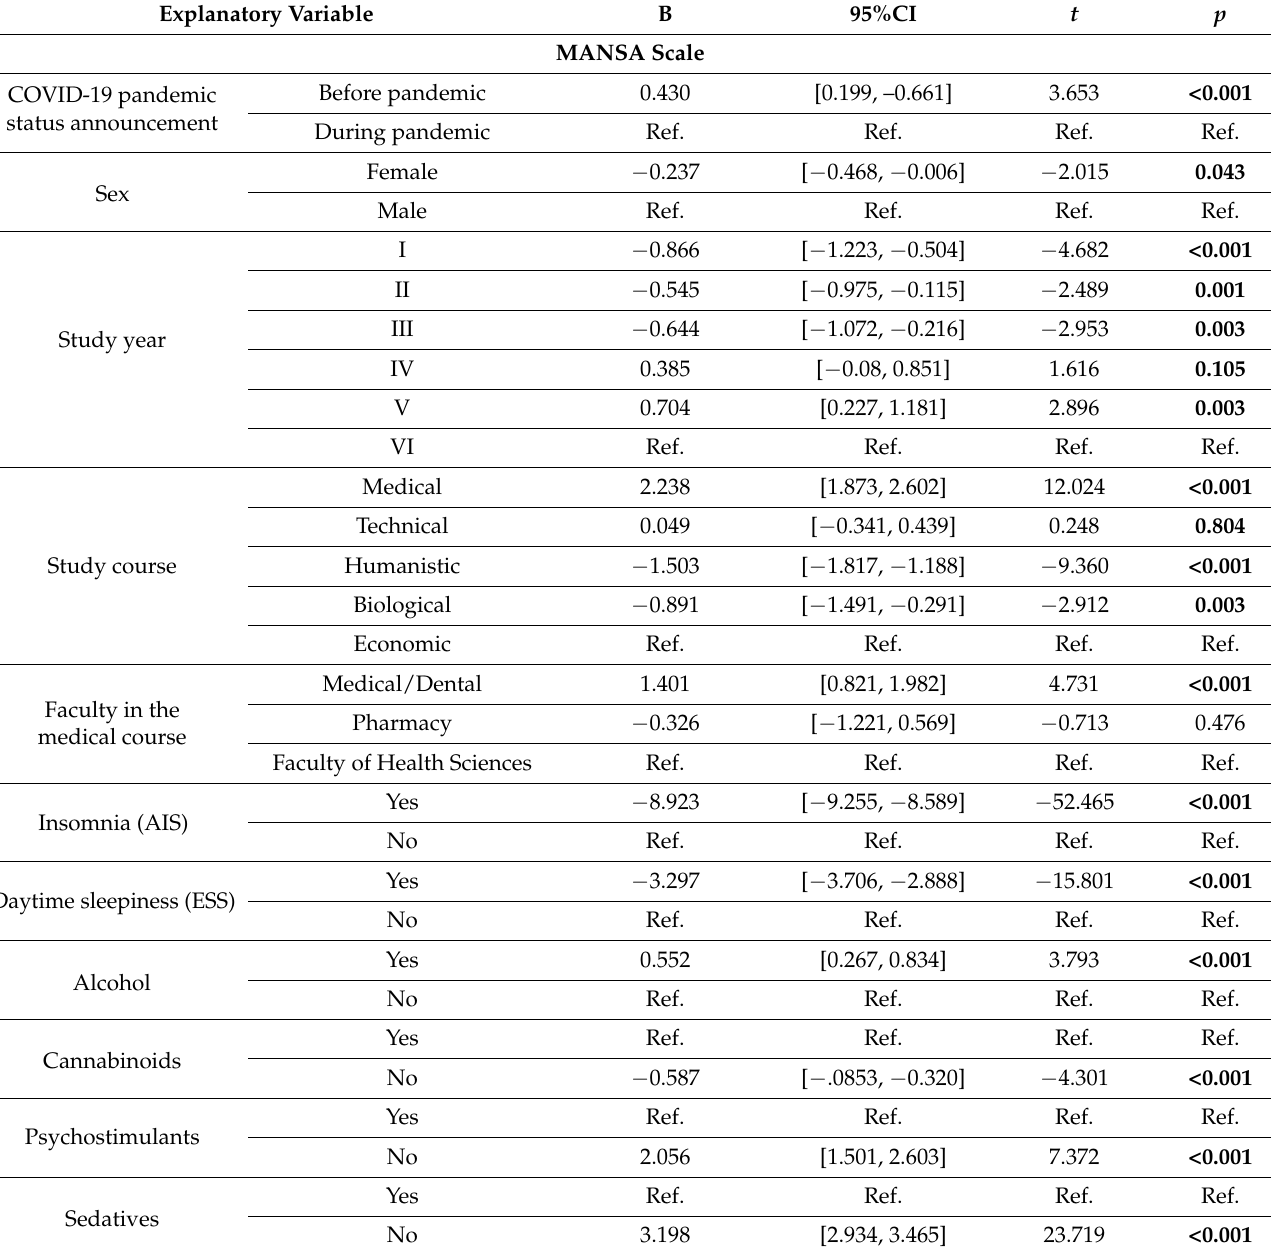
Table 3. Influence of sociodemographic variables, pandemic, stage of studies, insomnia, and daytime sleepiness on subjective QOL assessment in a linear regression model. Explanatory